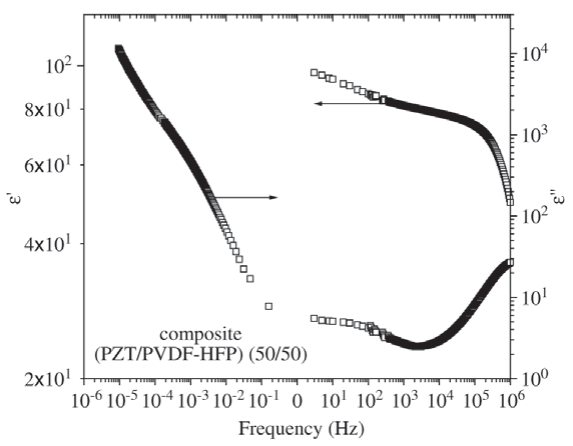
Figure 2. Real and imaginary parts of the complex permittivity for the PZT/PVDF-HFP composite (50/50